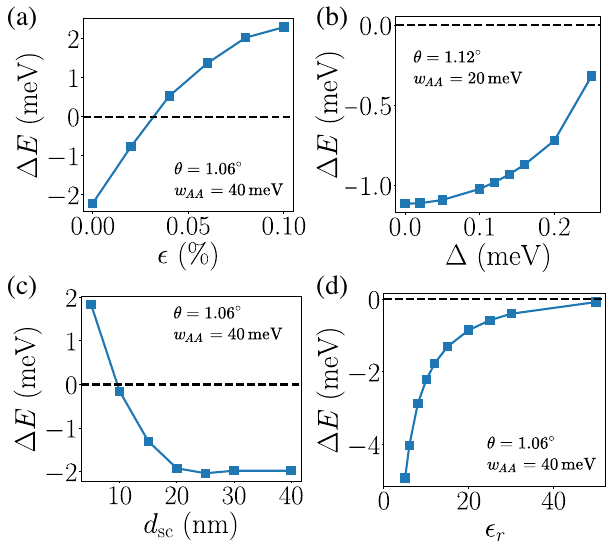
FIG. 6. Paired skyrmions and perturbations (spinless ν ¼ 0 ). Dependence of the relative energy of the paired skyrmion Δ E ¼ E − E 2 e skyr 2 e as a function of the (a) strain ratio coupling Δ , (c) gate screening distance d permittivity ϵ r . System size is 13 × 13 with the graphene scheme. Qualitatively similar results are obtained for the other schemes.